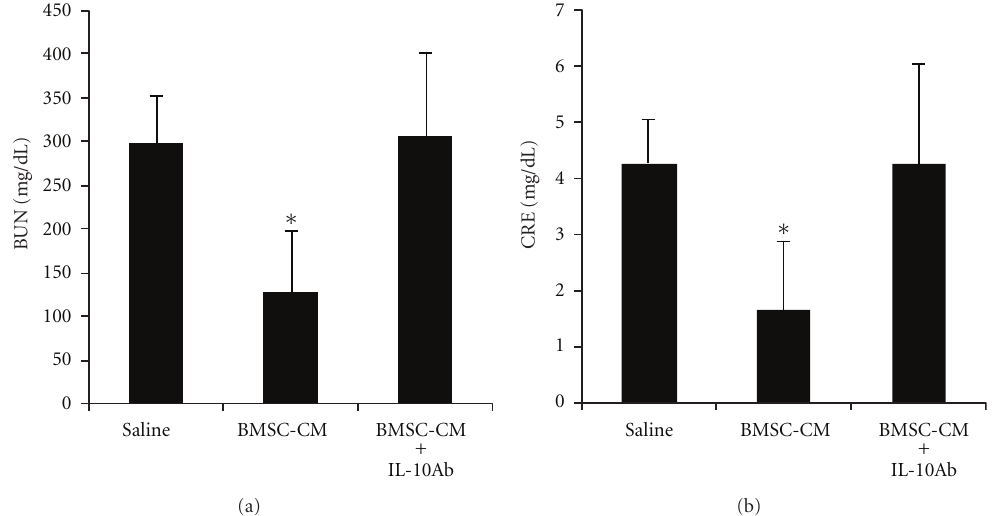
Figure 9: Protection of kidney function by BMSC-CM during AKI is abated with IL-10 antibodies . (a) Serum BUN and (b) serum creatinine values for rats subjected to cisplatin AKI and subsequently treated with either saline, BMSC-CM, or BMSC-CM with IL-10 neutralizing antibodies. Animals were sacrificed at 5 days after induction of AKI for blood collection. ∗ P < 0 . 05 by Student’s t